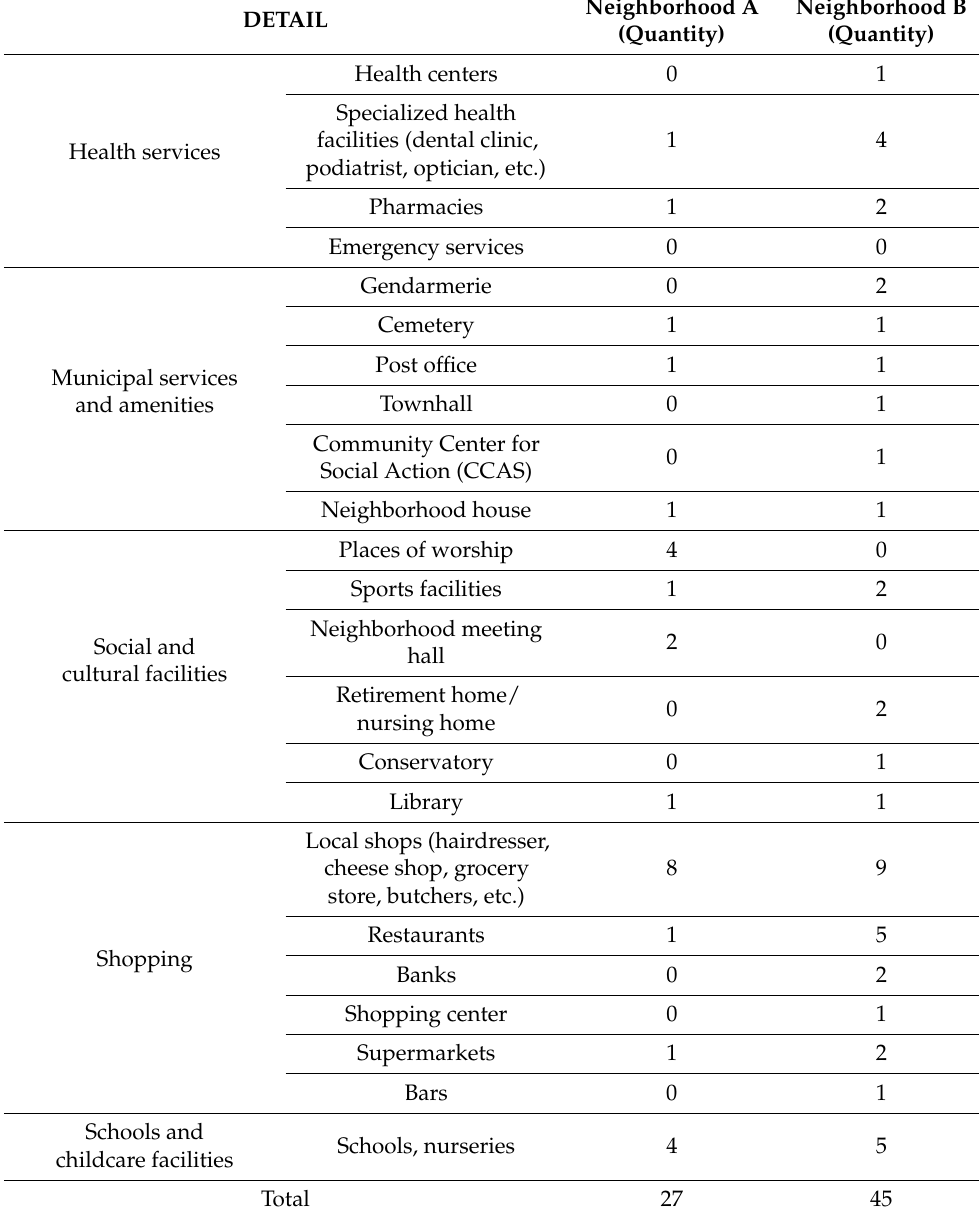
Table 1. Neighborhood services and